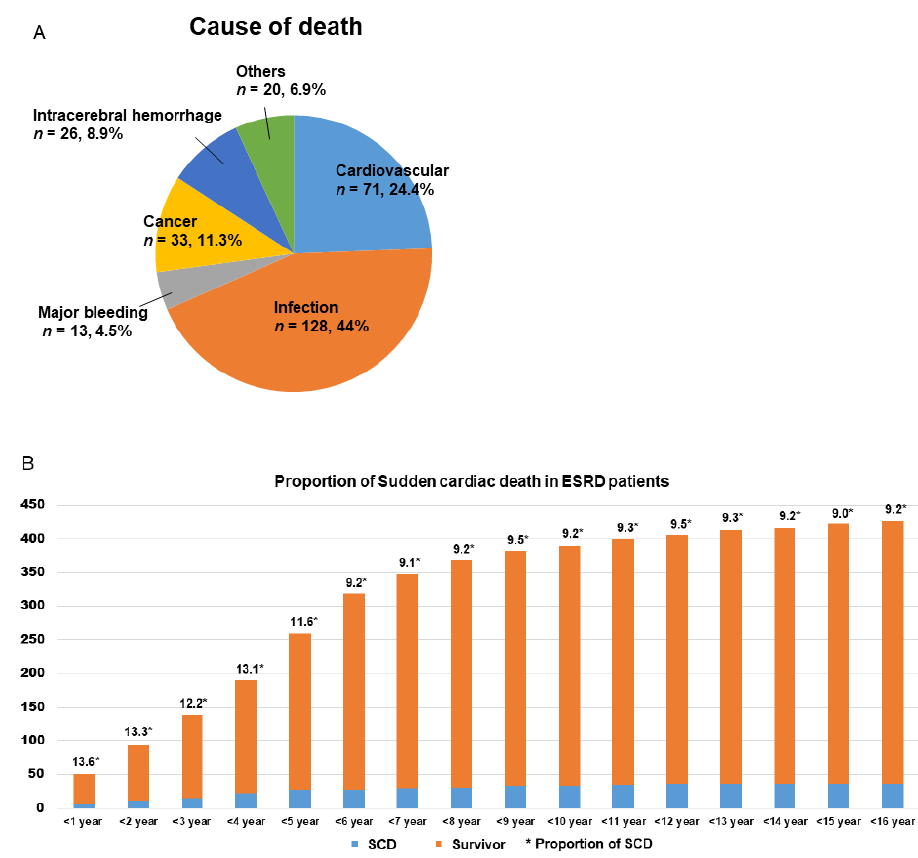
Figure 1. Cause of death and proportion of sudden cardiac death in end-stage kidney disease (ESRD) patients. ( A ) Cause of death in ESRD patients. ( B ) Proportion of sudden cardiac death in ESRD patients. ESRD